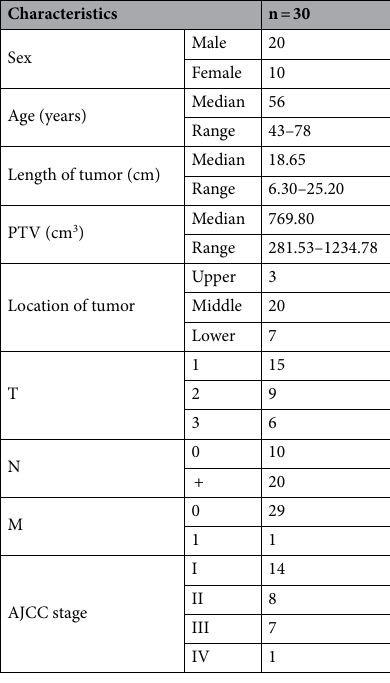
Table 1. Characteristics of EC patients in this study. PTV planning target